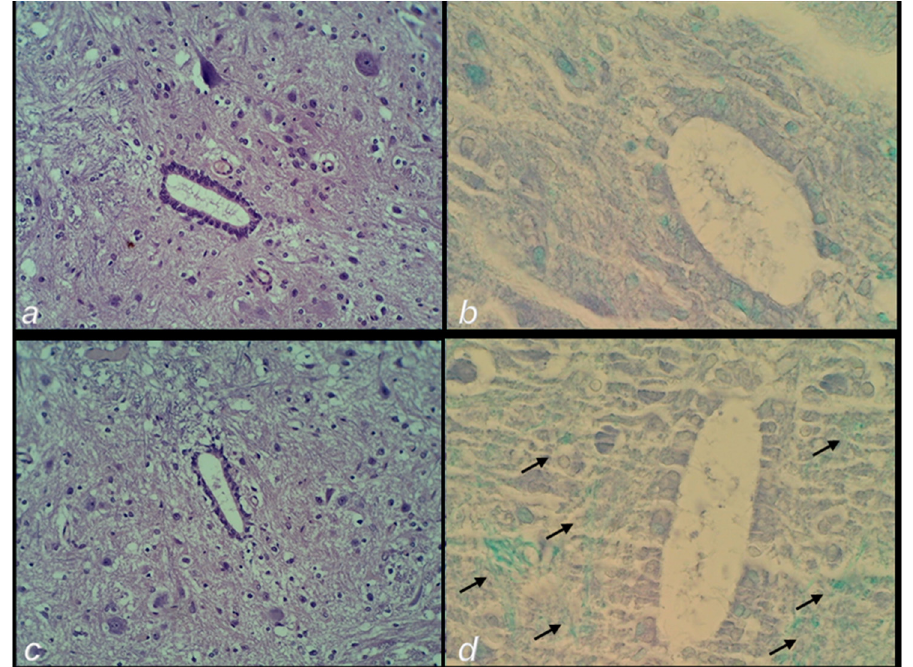
Figure 13. Post-injury day 30 with the therapy given since post-injury day 4. Neuropathological changes in the posttraumatic spinal cord in the intermediate grey matter at the lesion site. Control. Edema ( a ) and loss of neurons and loss of myelin fibers ( b ). BPC 157. Minimal edema ( c ) and with preserved myelin fibers (arrows) ( d ) (HE ( a , c ) and Luxol fast blue staining ( b , d ); magnification 400 × ).